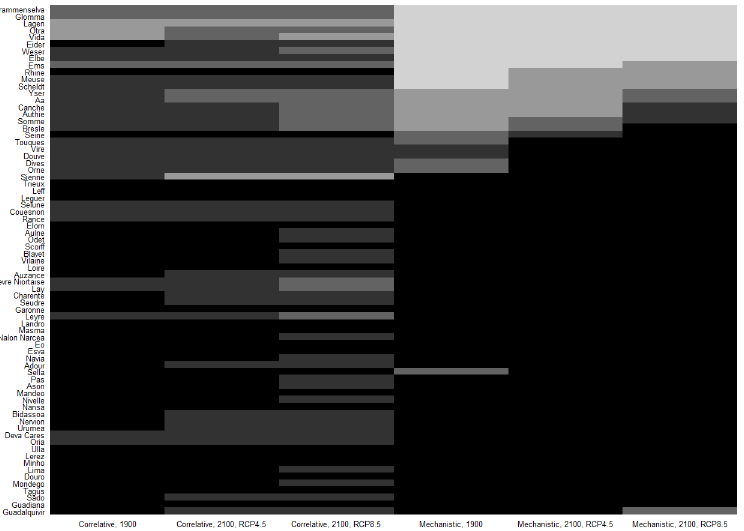
Fig 4. Heat map representing the probability classes for the 73 basins at the species historical core distribution range for the two times steps, i.e. 1901 – 1910 and 2070 – 2100, and for the two modelling approaches, i.e. the correlative and mechanistic SDMs, and the two climate change scenarios, i.e. RCP 4.5 and 8.5. Five classes 0,] 0 – 0.25],] 0.25 – 0.53],] 0.53 – 0.75], and]0.75 – 1] were represented by a continuous grey gradient with black used for the highest probability class] 0.75 – 1]. Basins were ordered along a latitudinal gradient (i.e., latitude at the basin outlet) from South (i.e., Guadalquivir) to North (i.e.,